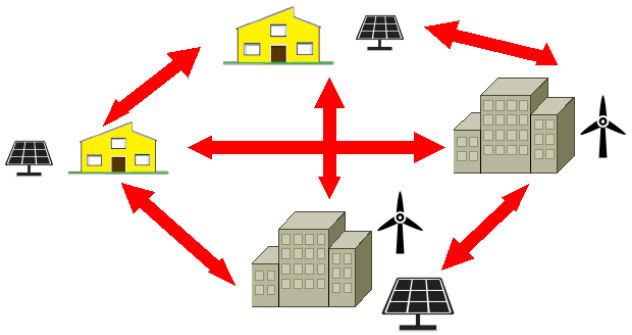
Fig. 2 . Full P2P model